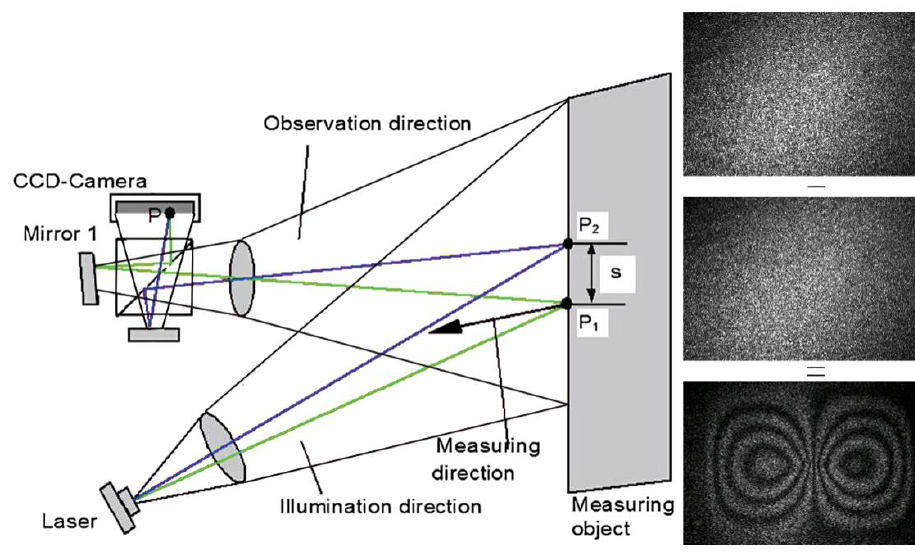
Figure 1. Fundamentals of digital shearography.